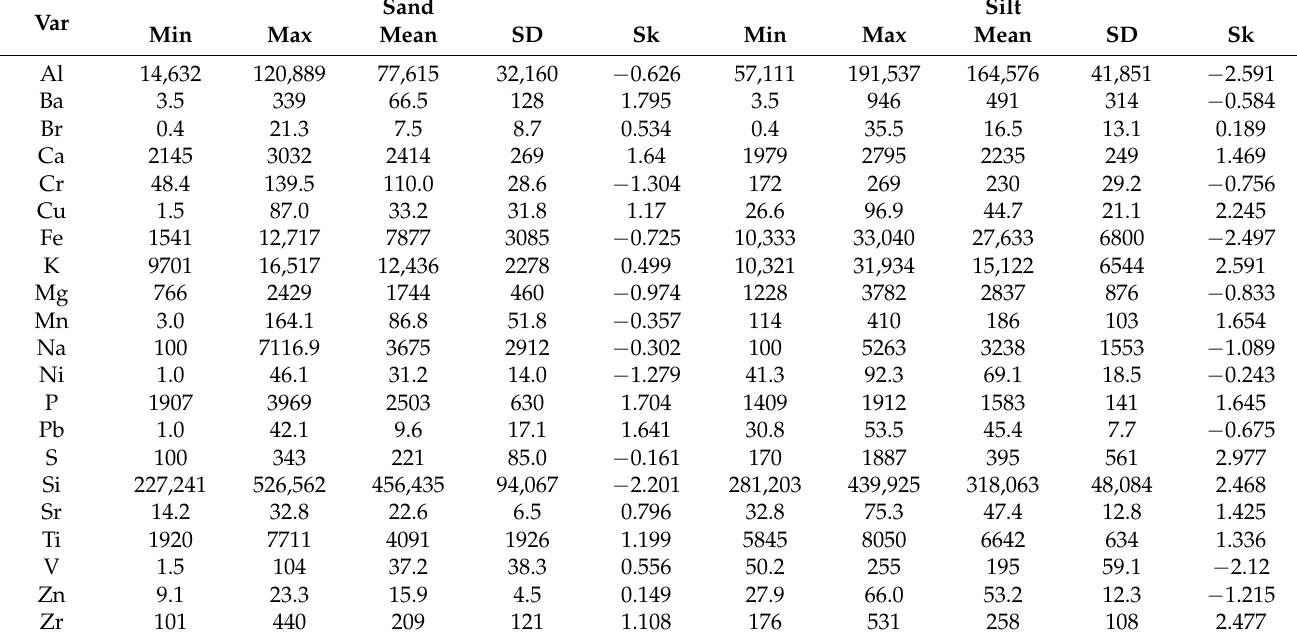
Table 3. Statistical chemical composition summary of studied samples sand and silt